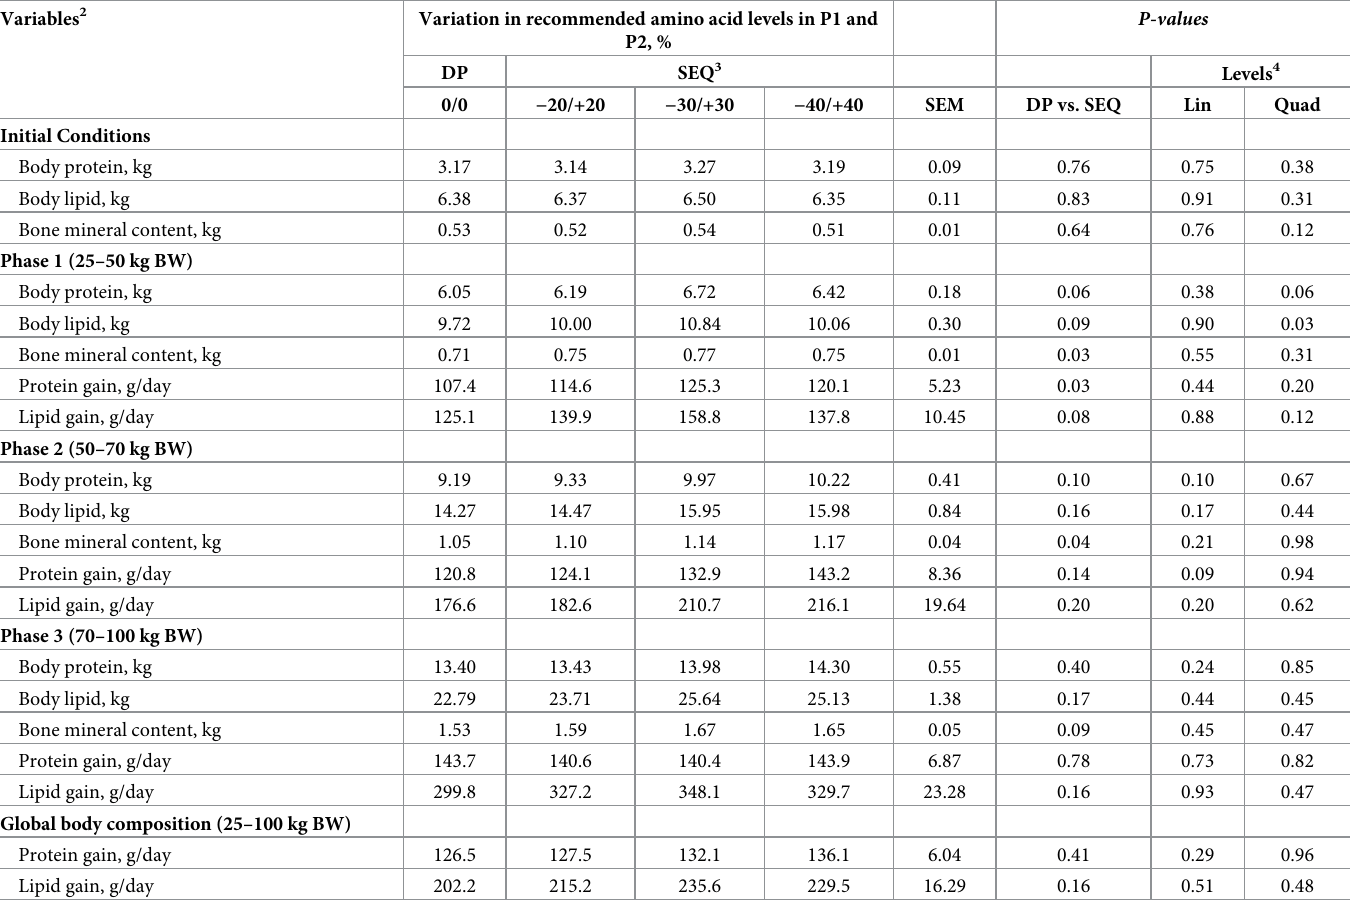
Table 3. Body composition of pigs in a daily feeding program (DP) or in a sequential feeding program (SEQ) with different levels of variation in amino acid (AA) concentration throughout the day 1 . Variables 2 Variation in recommended amino acid levels in P1 and P2,